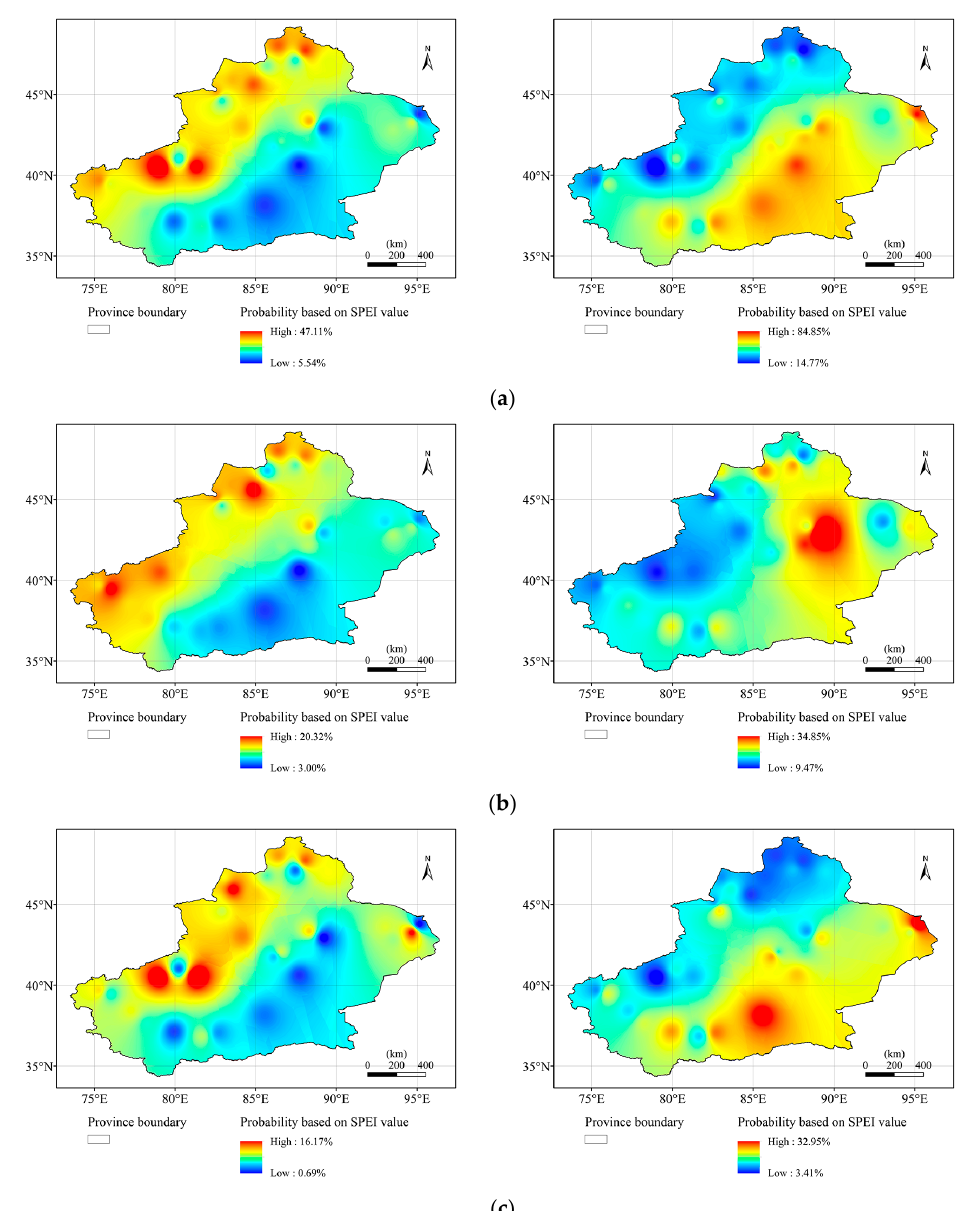
Figure 12. Cont. Figure 12.